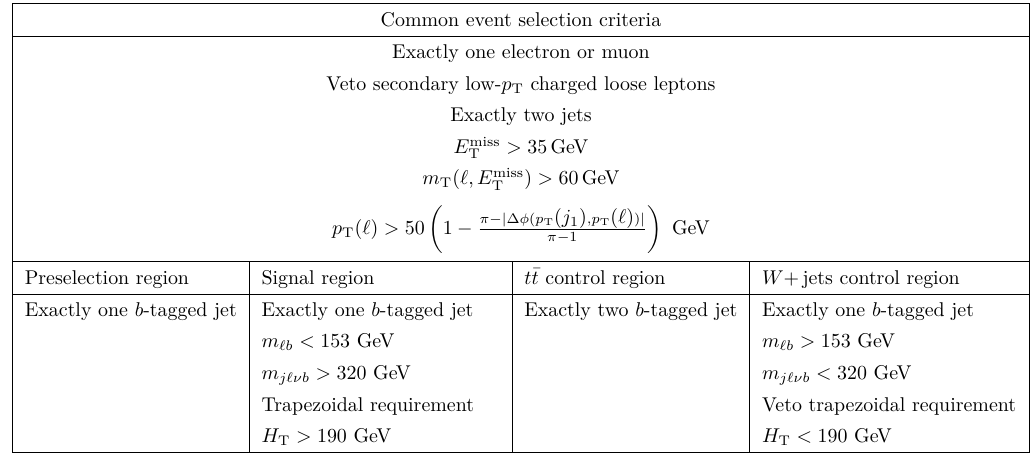
Table 1 . Summary of the selection criteria defining the preselection, the signal region and the two control